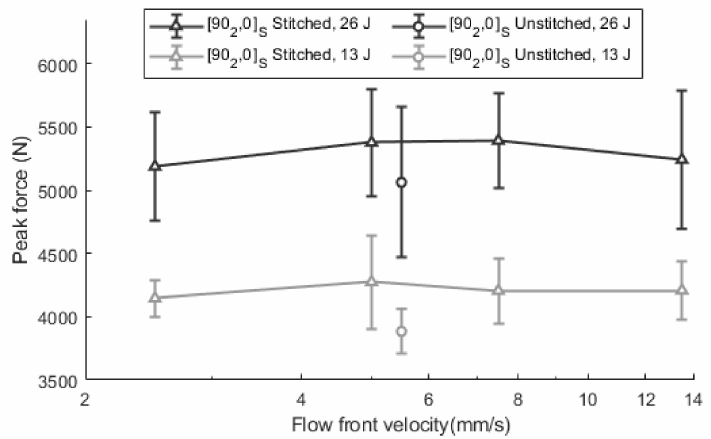
Figure 8. Maximum impact force in [90 2 , 0] S in stitched and unstitched laminates at 13 J and 26